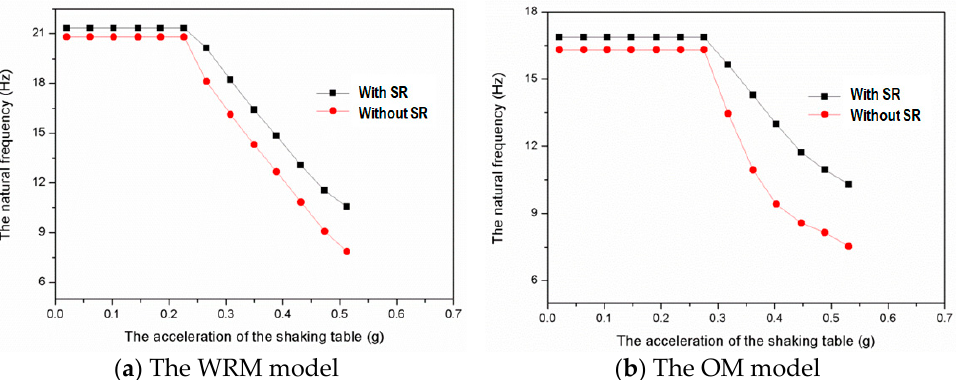
Figure 4. The variation of natural frequency with acceleration.